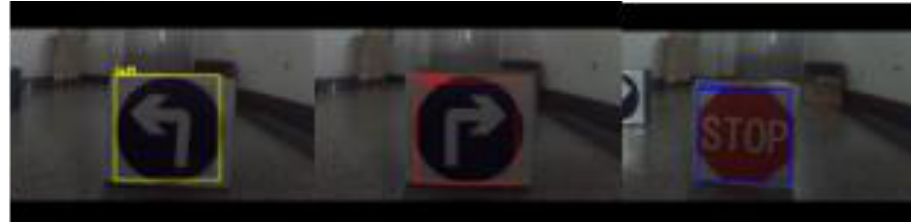
Figure 20. Real-time picture of road sign detection.